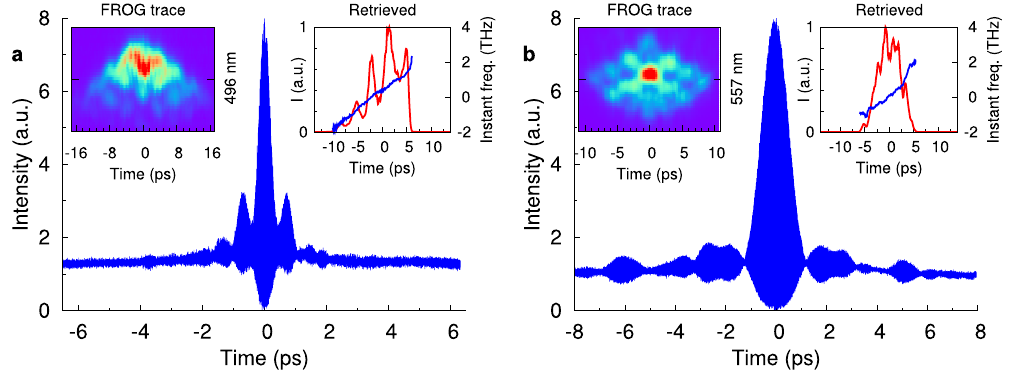
Figure 4. Temporal characteristics of the generated anti-Stokes ( a ) and Stokes ( b ) pulses: Interferometric ACF for a compressed pulse, FROG trace (left inset) and retrieved pulse amplitude and instantaneous frequency (right